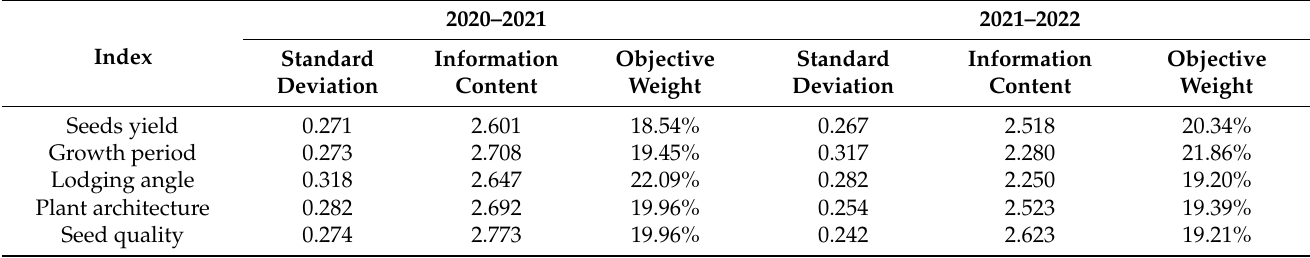
Table 3. Weight of each indicator based on the D-CRITIC method for the growing seasons of 2020– 2021 and 2021–2022.